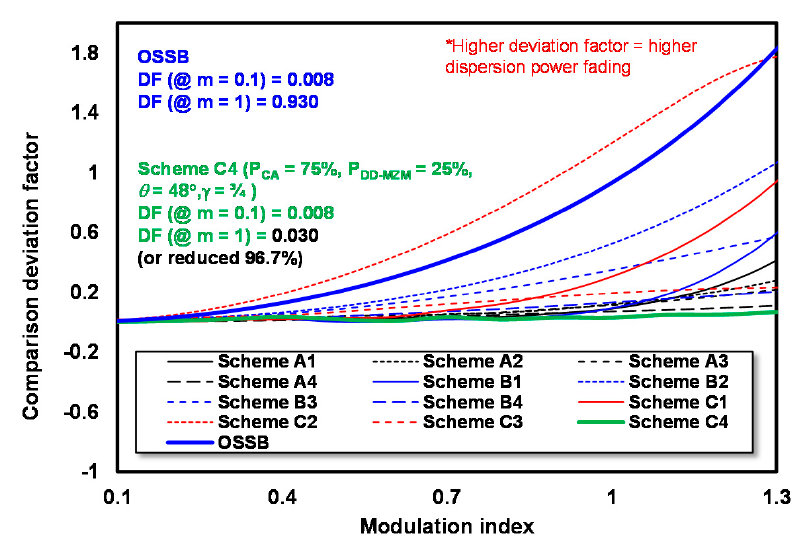
Figure 11. DF value of irregular θ for all schemes.